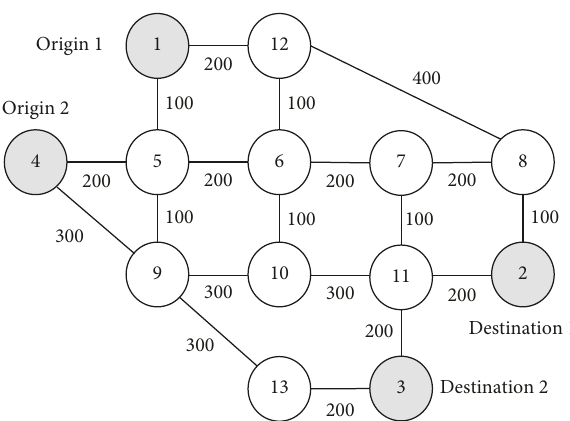
Figure 6: The road network structure for